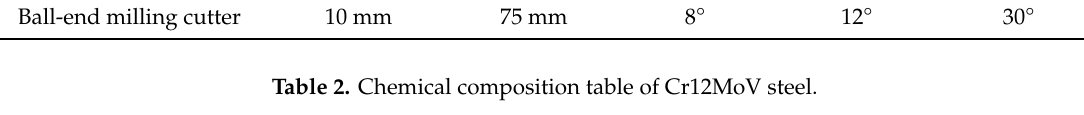
Figure 10. Simulation results of surface topography after removal of curvature. ( a ) Residual height z after removal of curvature; ( b ) three-dimensional image after removing curvature.